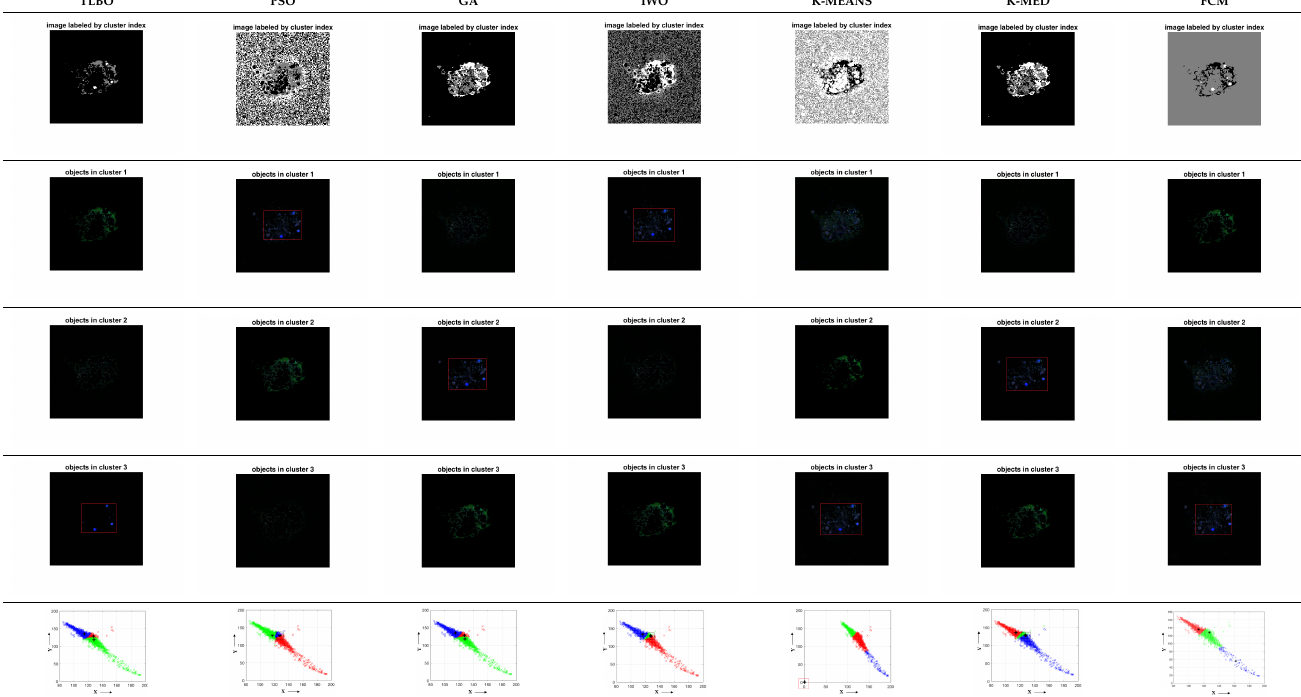
Figure 5. Comparative analysis between teacher learning based optimization (TLBO) and other existing nature-inspired clustering techniques using 2:0.5 ratio slices based on ( a , b ) quantization error (QE) and ( c , d ) best cost (BC). Table 1. Comparative Analysis of visual results of TLBO with other clustering algorithms for 2:0.5 ratio image of Figure 1a.